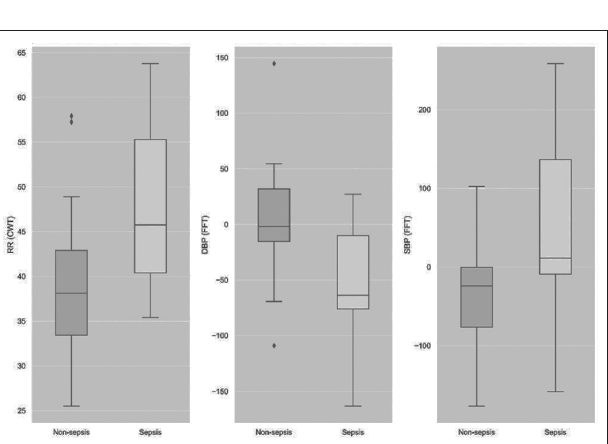
FIGURE 3 | Statistical significance ( p < 0.001) was observed among the three physiological signals, namely, respiratory rate, diastolic blood pressure, and systolic blood pressure at 12h prior to sepsis